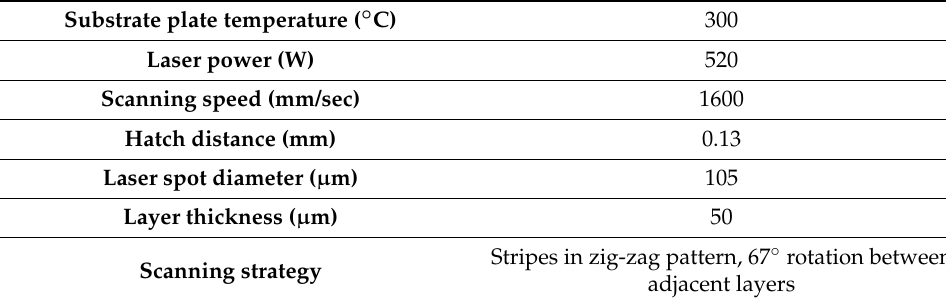
Table 3. Overview of the used LPBF process parameters.